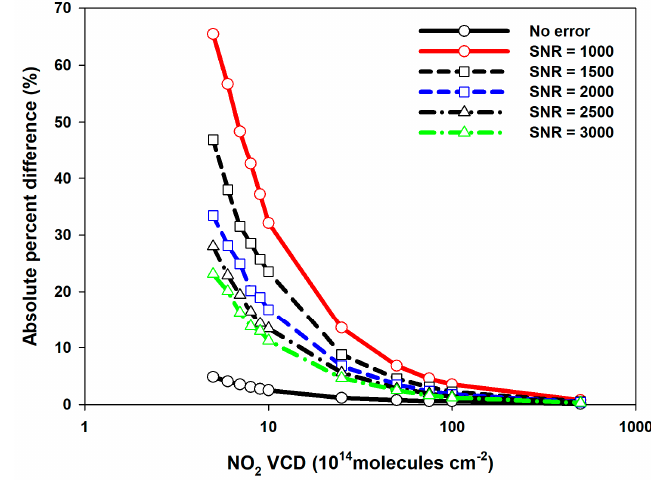
Figure 7. Absolute percentage difference (APD) between true and retrieved NO 2 SCDs as a function of NO 2 VCD under various SNR conditions. (SZA = 20°; VZA = 20°; RAA = 50°; SSA = 0.95; AOD = 0.1; APH = 0 km). (Slant column density (SCD), vertical column density (VCD), signal-to-noise ratio (SNR), solar zenith angle (SZA), viewing zenith angle (VZA), relative azimuth angle (RAA), single scattering albedo (SSA), aerosol optical depth (AOD) and aerosol peak height (APH)).